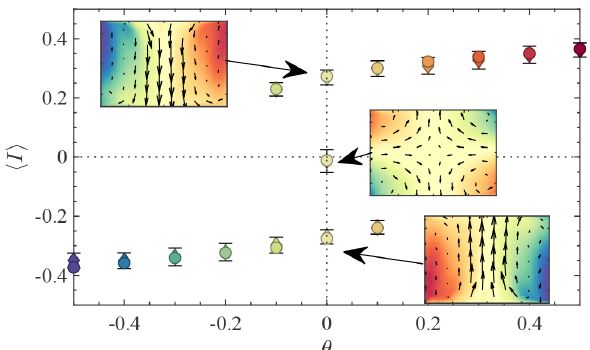
Figure 5. Seasonal cycle in the von Kármán experiment for a case with high fluctuations. The response of the mean vertical angu- lar momentum (cid:104) I (cid:105) to an asymmetry θ is now discontinuous. The spring/autumn branch is now reduced to the single central point here, disconnected from the austral and boreal summer branches, which are respectively defined as the continuous branch extending to θ → + 1 (respectively θ → − 1) using notations consistent with Figs. 3 and 4a. Transitions are only possible from the spring branch to one of the summer states or between the two summer states. Three distinct flow configurations are then possible for − 0 . 05 ≤ θ ≤ 0 . 05. Their topology is recalled in the